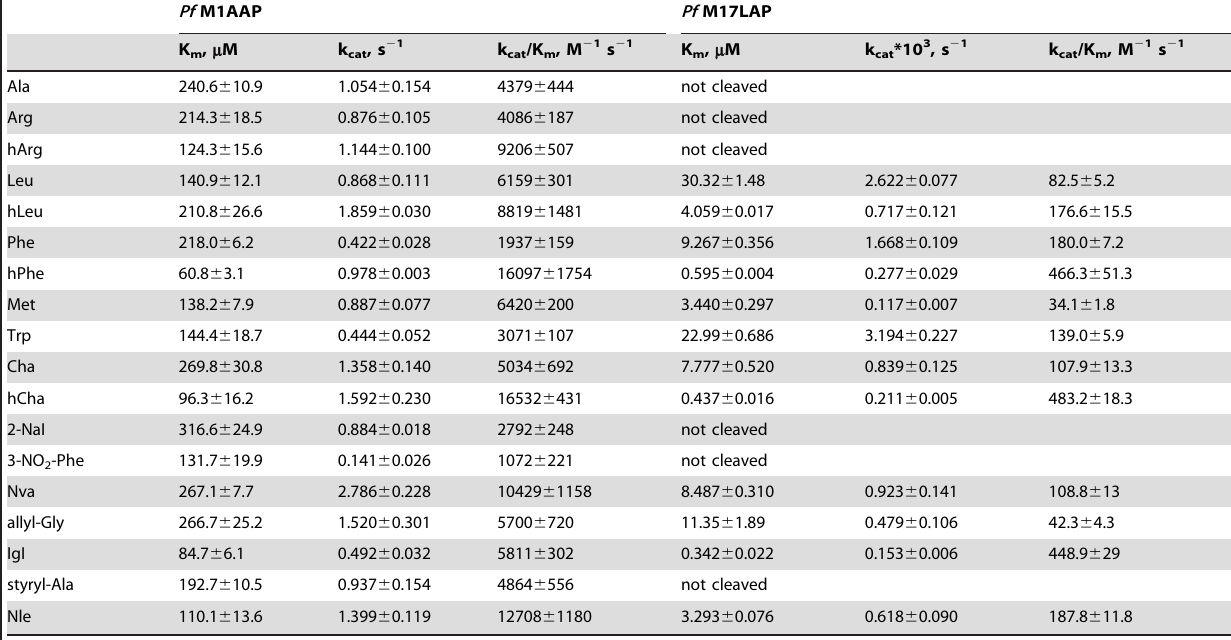
Table 1. Kinetic parameters for selected substrates.